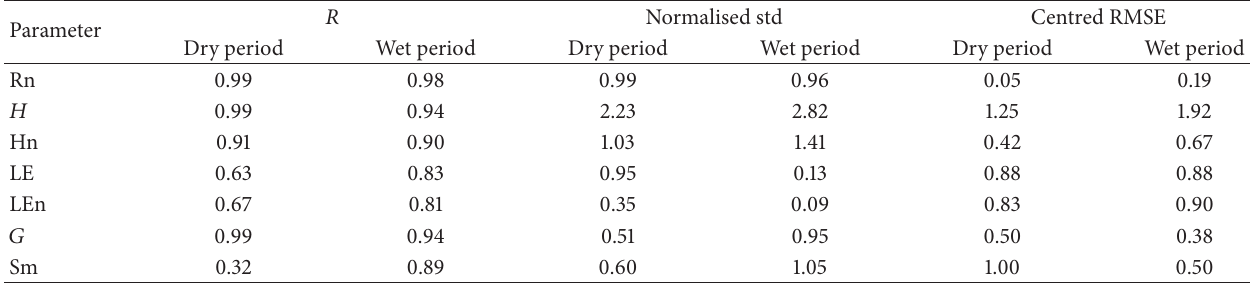
Table 3: Summary of the statistical comparison of the simulated variables against the observed variables for several performance measures: correlation coefficient 𝑅 , normalized standard deviation 𝜎 , and centred root mean square error